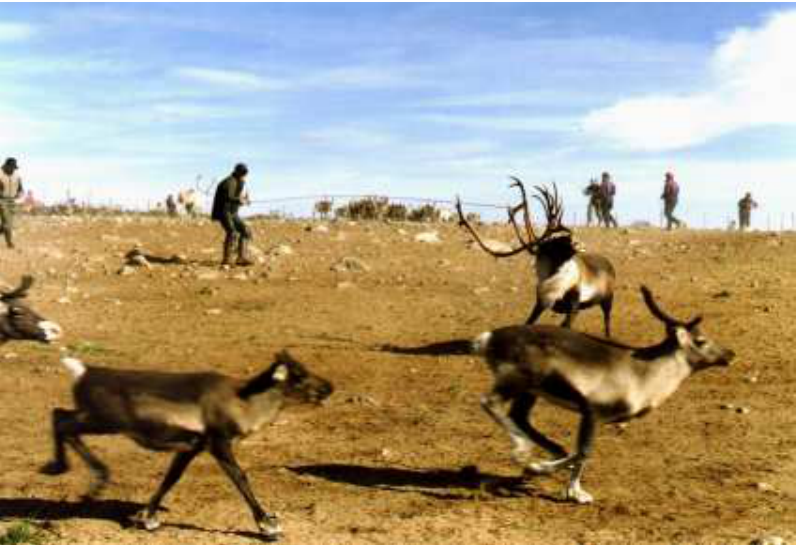
Fig. 1. Stress före slakt kan ge förhöjda pH-värden och försämrad hållbarhet på köttet. Kortisol, ASAT och urea är expempel på stressmetaboliter som ökar i blodet vid hantering, blödningar i löpmagens slemhinna kan också utvecklas snabbt vid akut stress (Foto: E.